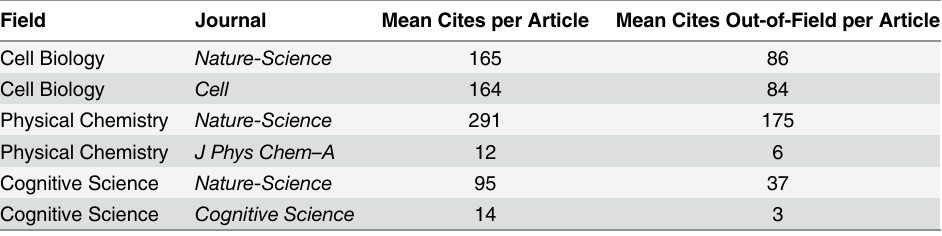
Table 2. Mean number of total citations per article and mean number of citations per article appearing in journals that are out-of-field, by